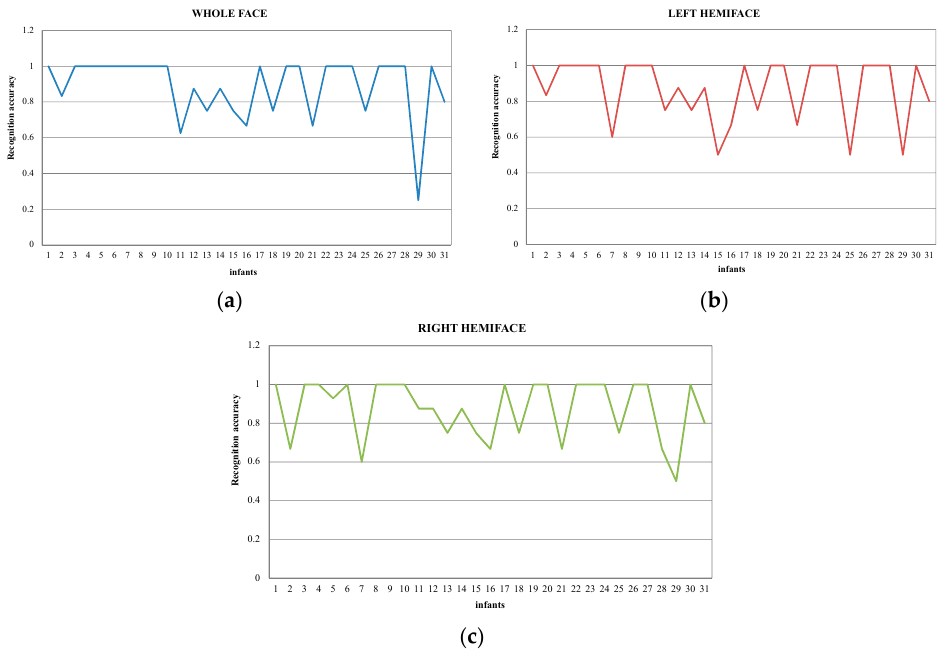
Figure 4. Individual accuracies of whole face and hemiface models; ( a ) Whole face ( b ) Left hemiface ( c ) Right hemiface.